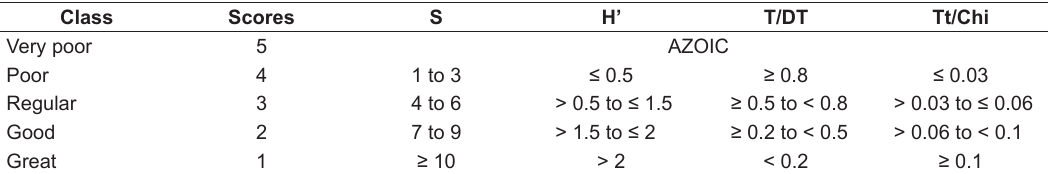
Table 3. Water quality classification for Benthic Community Index (ICB 2012).